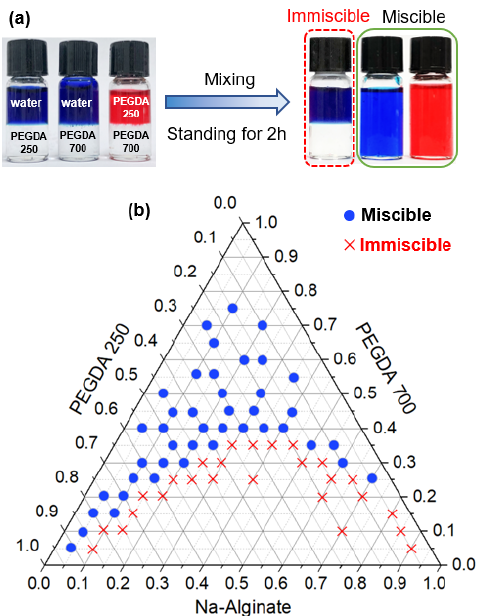
Figure 2. ( a ) Digital photographs showing the miscibility of three liquids. The deionized water (DI) water contained a water-soluble blue dye, and poly(ethylene glycol) diacrylate 250 (PEGDA 250) contained an oil-soluble red dye when mixed with PEGDA 700. After enough time for mixing, bottles stood for 2 h. PEGDA 250 was immiscible with water, whereas PEGDA 700 was miscible with both PEGDA 250 and water. ( b ) Ternary phase diagram illustrating the solubility of three solutions in this phase separation system. The blue dots mean that the three solutions were miscible at that volume ratio and the red crosses indicate that the three solutions were immiscible at that volume ratio.